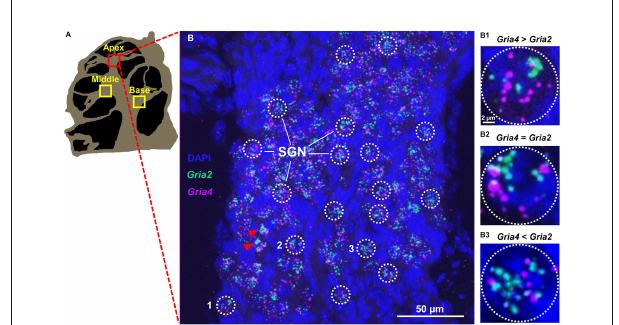
FIGURE1 Specific expression of Gria2 and Gria4 mRNA puncta on SGN. (A) A computer-generated sketch of a cochlear section through the modiolus. The spiral ganglion (indicated with squares) is located on the modiolar side of sensory epithelia and contains a group of neuron cell bodies (the spiral ganglion neurons, SGNs). (B) A representative maximum-intensity projection of a confocal stack of images of SGNs of the apical cochlea turn of a male mouse with mRNA signal for Gria2 (green) and Gria4 (magenta), and DAPI nuclei staining (blue). The mRNA signal for Gria2 and Gria4 is observed as puncta grouped around large DAPI nuclei. ROIs (white dotted line circles) correspond to individual SGNs. Red arrowheads point to SGNs that were excluded due to puncta clustering. (B1–3) High magnification of the three SGNs (1, 2, and 3) containing different ratios of Gria2 and Gria4 puncta. In (B1) , the SGN has more Gria4 puncta than Gria2 . In (B2) , the SGN has equal amounts of Gria4 puncta and Gria2 . In (B3) , the SGN has less Gria4 puncta than Gria2 . See Section “Methods” and Figure 6 for details of the quantitative